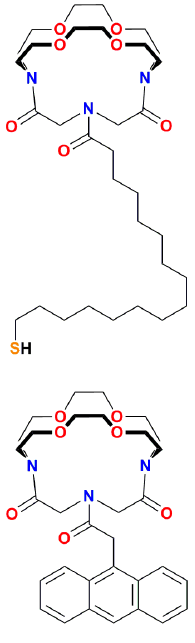
Scheme 13. Cryptand-based sensors 30 ( top ) and 31 ( bottom ).